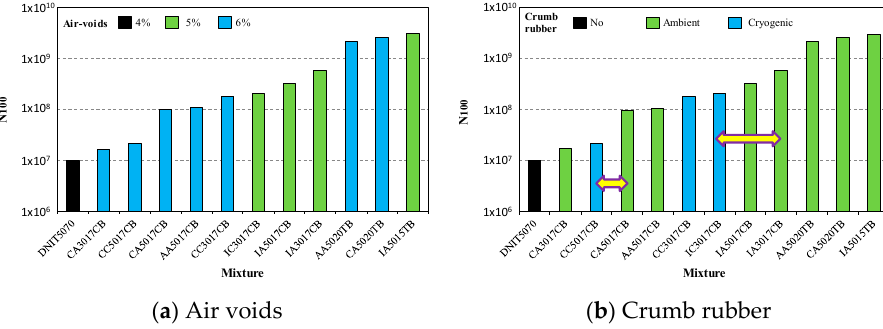
( b ) Crumb rubber Figure 8. Influence of air voids ( a ) and crumb rubber ( b ) on fatigue resistance. In terms of the base asphalt, it is not clear how it influenced the asphalt rubber mix- tures because, as indicated in Figure 9a (see CA3017CB vs. CA5017CB; CC5017CB vs. CC3017CB; IA5017CB vs. IA3017CB), different influences were observed. In these two cases, a stiffer asphalt base contributed to the enhancement of fatigue resistance in the asphalt rubber mixtures. The asphalt rubber production system influenced fatigue perfor- mances in an positive manner. Asphalt mixtures from the terminal blend system pre- sented better fatigue resistance (Figure 9b), and this was also observed for gap mixtures (ADOT and Caltrans gradations) and for the dense mixture (AI gradation).